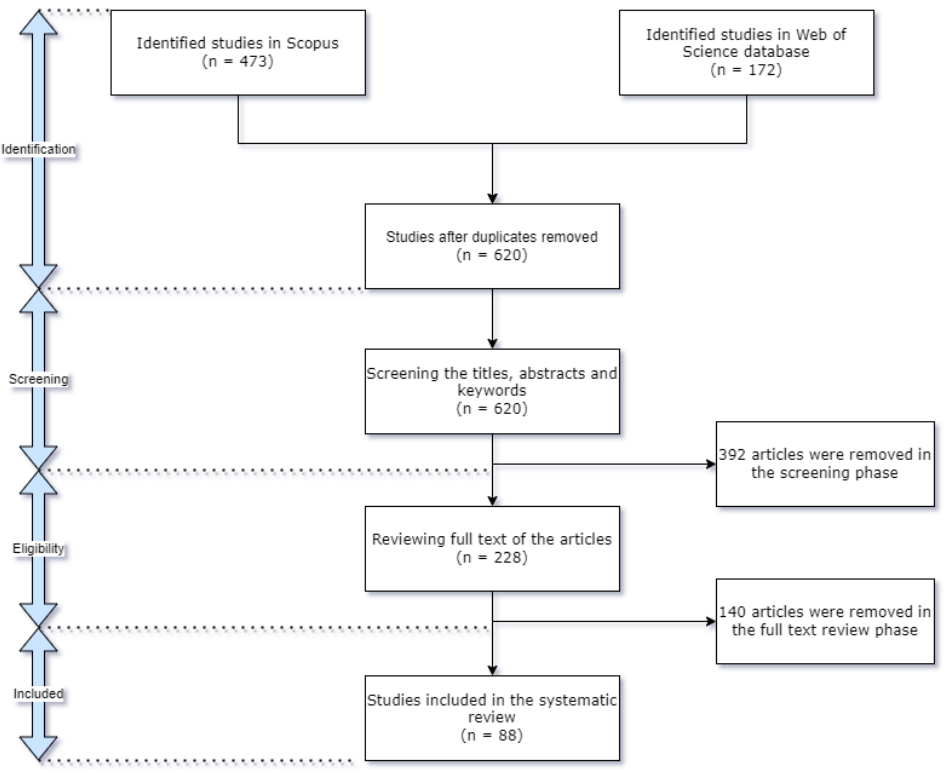
Figure 3. Summary review protocol.